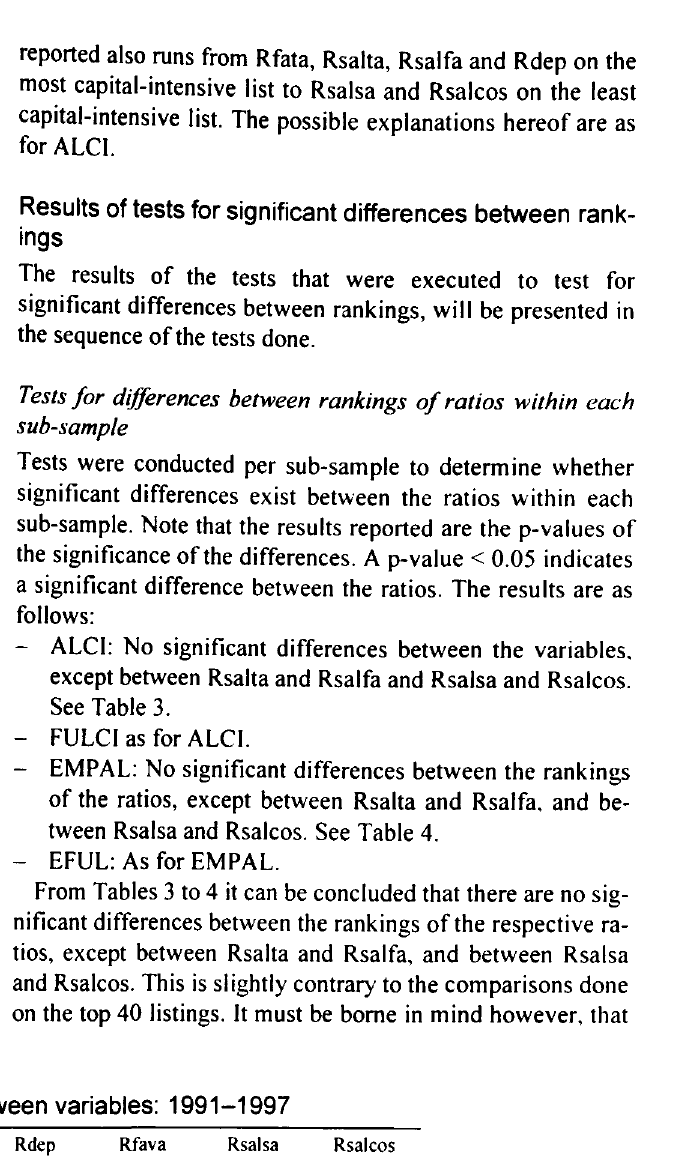
Table 4 EMPAL: Test for differences between variables: 1991-1997 Variables Rfata